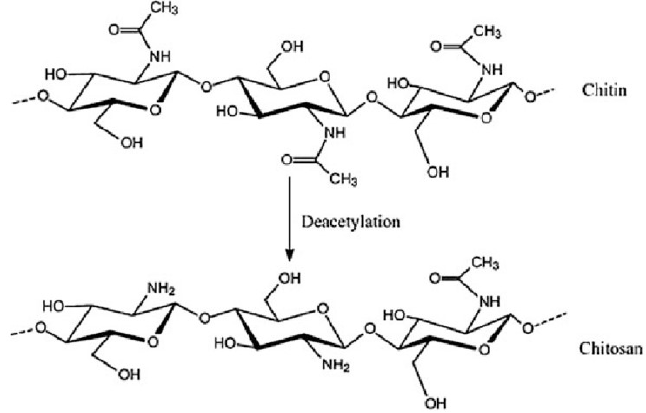
Figure 6. Structure of chitin and chitosan.